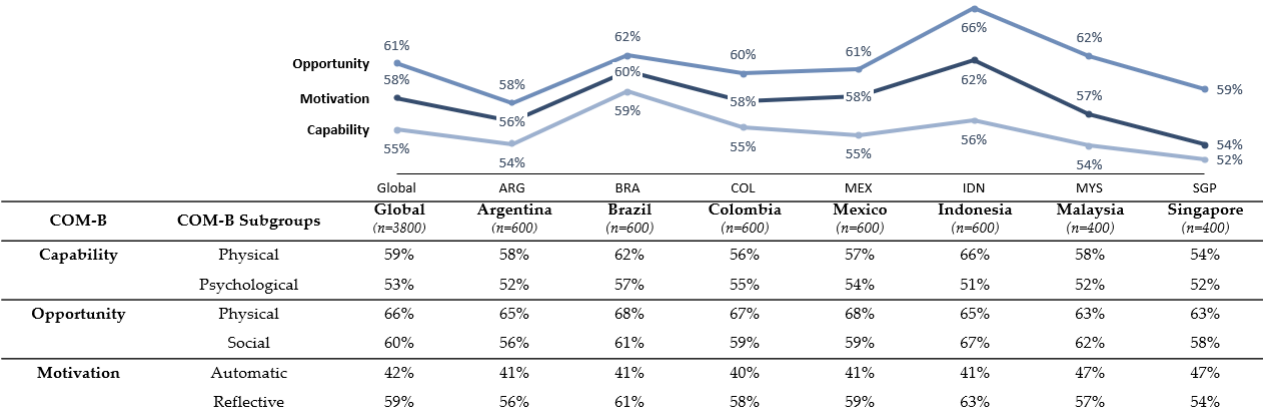
Figure 3. Capability, Opportunity, and Motivation overall composite score and individual factor scores globally and by country.